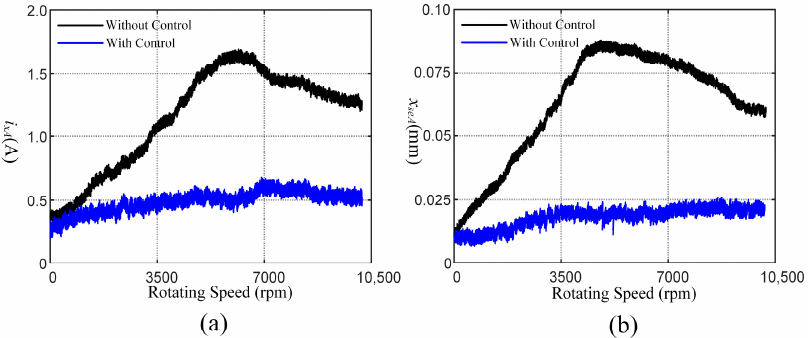
Figure 13. Experimental results of the overall control scheme in full rotating speed range: ( a ) Current vibration amplitude without and with control; ( b ) Displacement vibration amplitude without and with control.